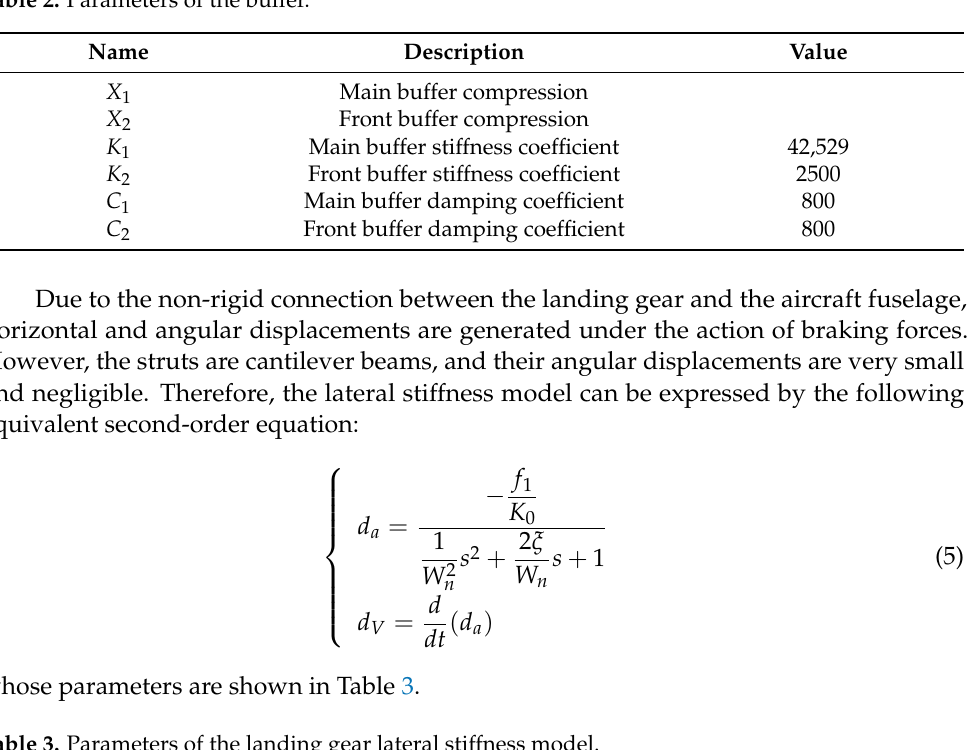
Table 3. Parameters of the landing gear lateral stiffness model.